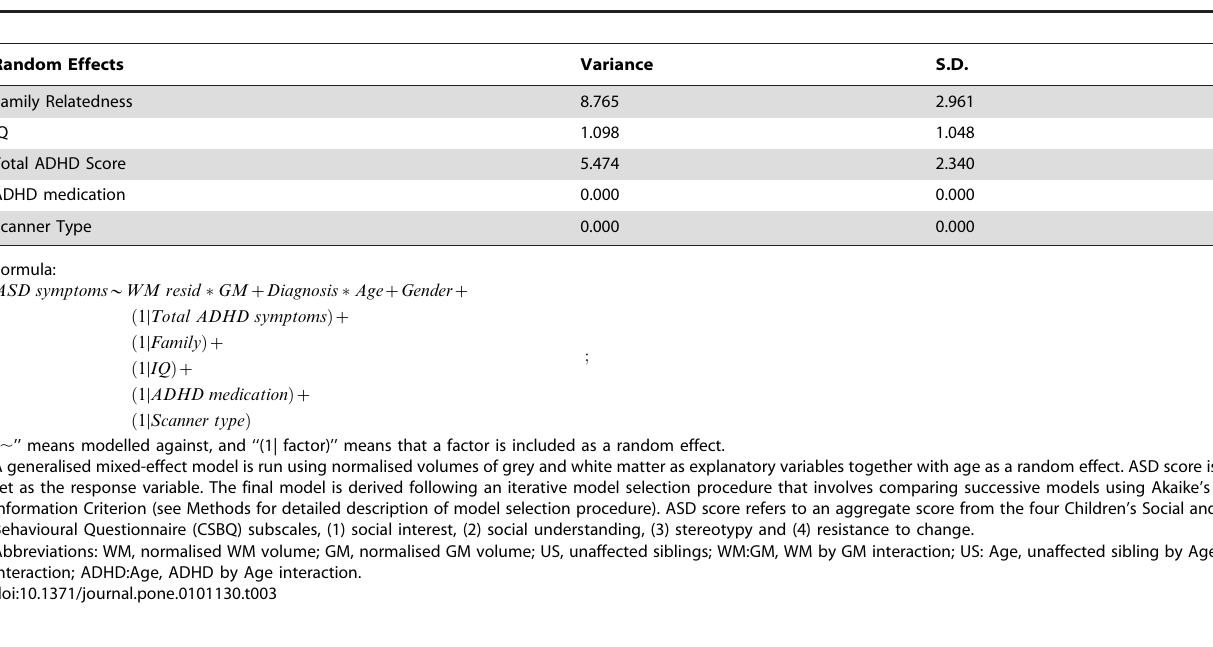
Table 3. Final, generalised mixed-effect model showing random effects for ASD score modelled against white matter residual and grey matter volumes.